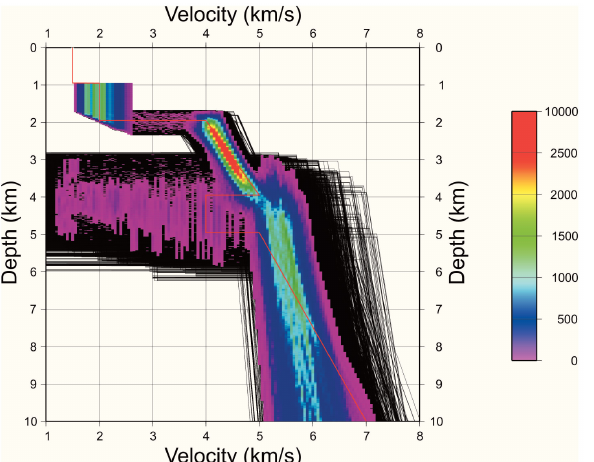
Fig. 16. Results obtained after using the Metropolis algorithm on data from model 2 and 10Hz for 40000 cases considering a “con- servative” picking avoiding picks in the “interference zone”. Red line represents the real model and every black line a modified model. The colour scale stands for the number of times that a model (or part of it) is visited.